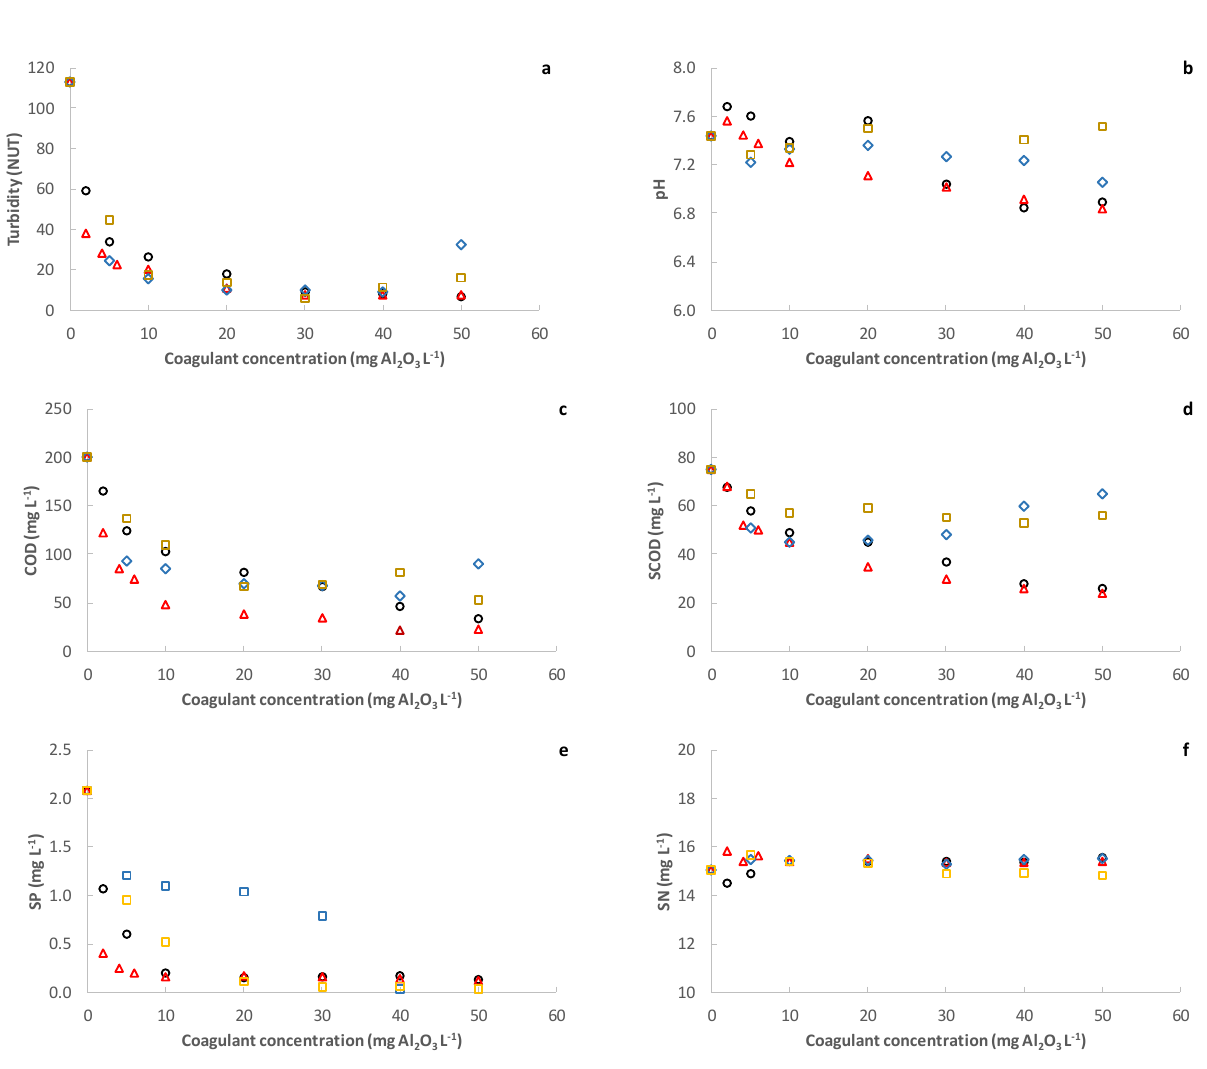
Membranes 2022 , 12 , x